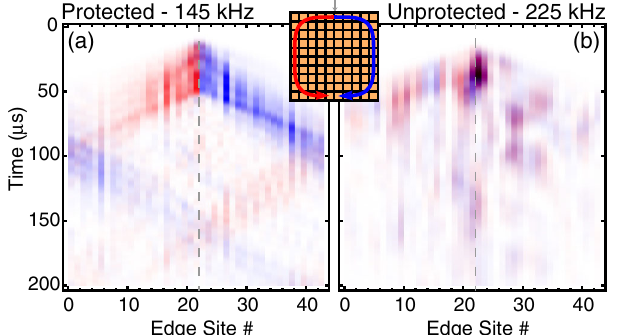
FIG. 4. Topological insulator with Möbius global topology. (a) Schematic Möbius topological insulator. Top diagram: Möbius TI, with the arrow indicating the edge propagation direction, and color the spin state. Bottom diagram: Connectivity of the Mobius TI. PCB is shown in orange, with external connections generating the topology indicating spin on traversing the edge. This circuit is excited in the edge channel at 145 kHz, within the largest bulk gap, and the subsequent evolution of the wave packet around the full perimeter of the system is observed through time. (b) Spin-resolved detection of edge transport after excitation of ↑ ; ↑ and ↓ intensities are plotted in the red and blue channels, respectively, showing the conversion from ↑ to ↓ when the excitation moves from one edge to the other. Three round trips are